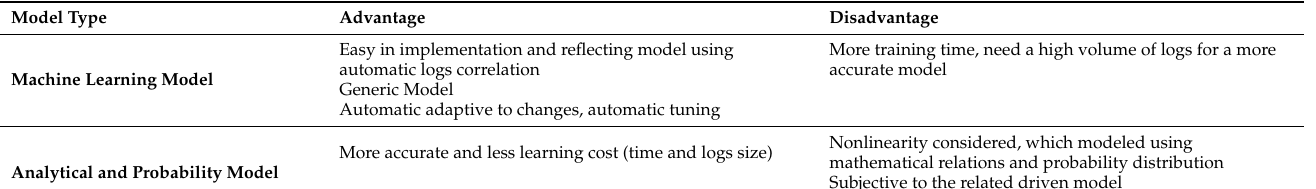
Figure 15. Alibaba Data Center Provision Resources for WL1. Table 4. Comparison Between Machine Learning and Analytical Modeling